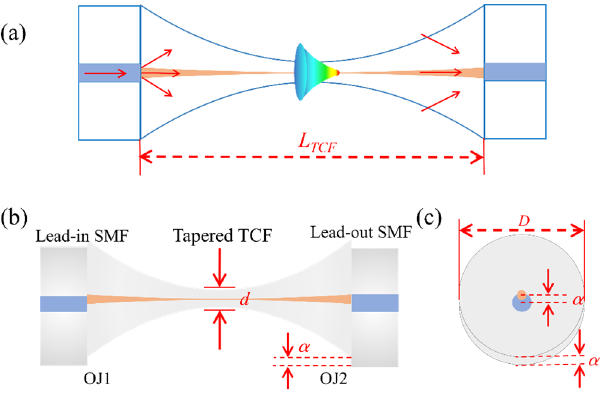
Figure 1. The schematic diagram of the t -TCF structure. ( a ) Top-view, ( b ) side-view and ( c ) cross- sectional view.